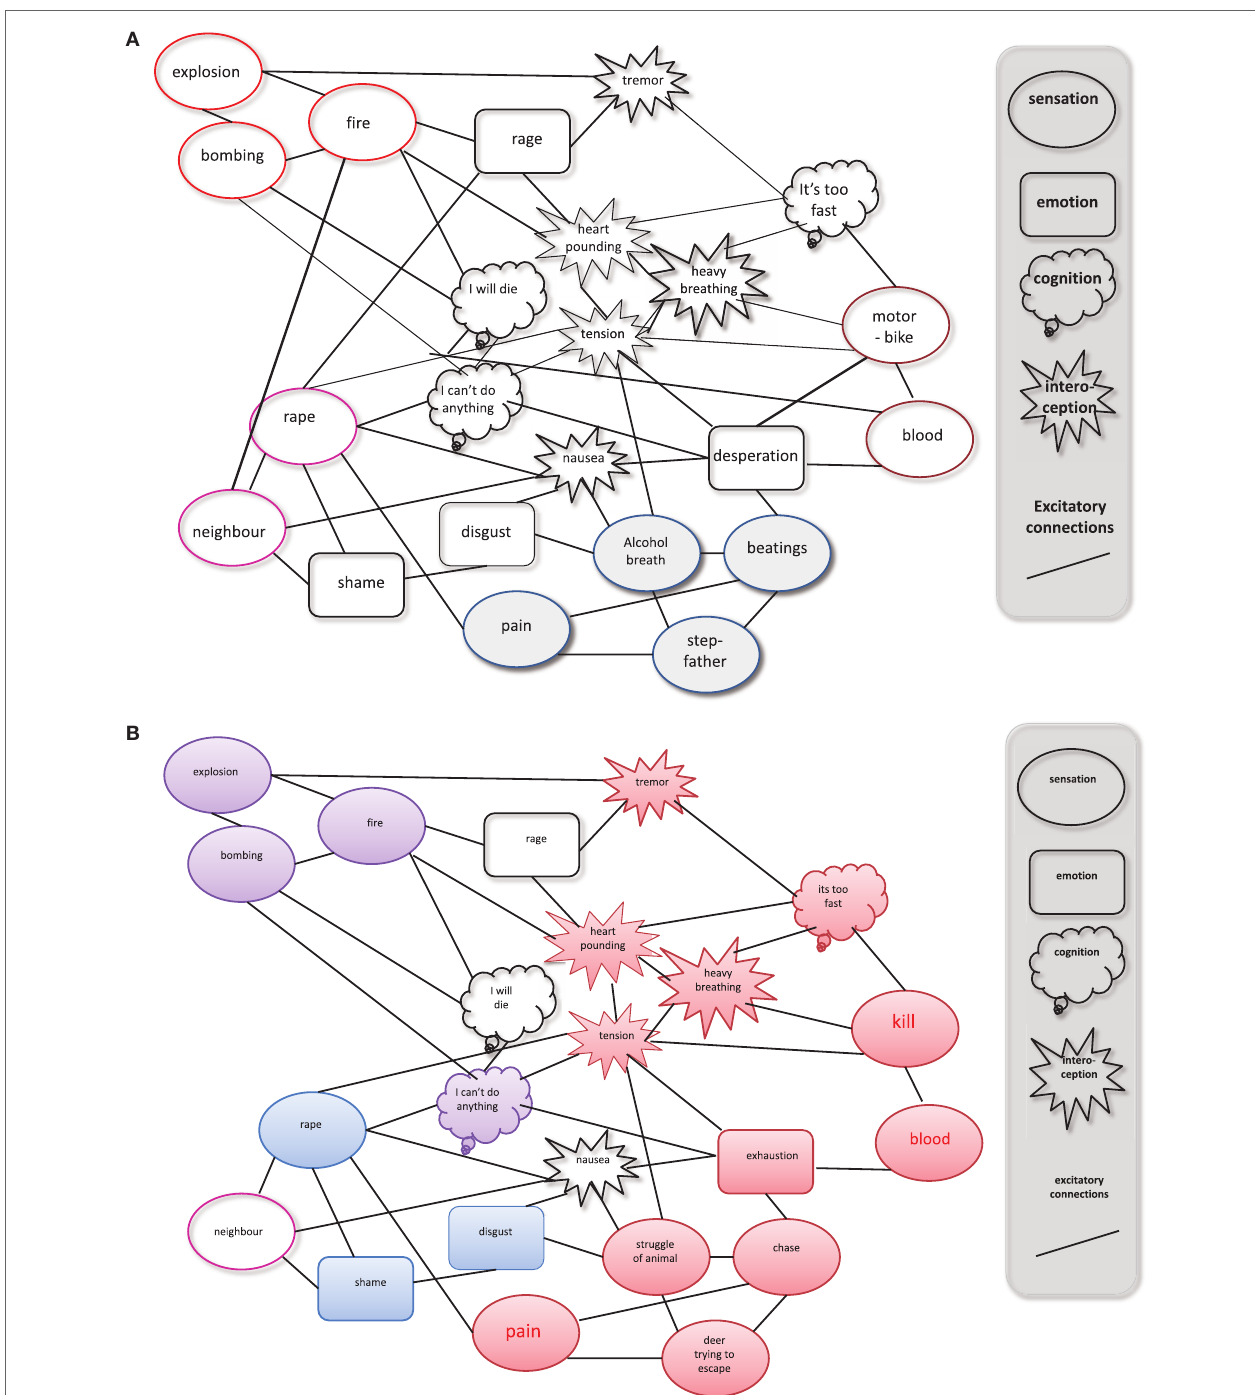
remain largely implicit, making it impossible for the traumatized person to talk about them, a phenomenon, which has been called “speechless terror” (34, 35). (B) Hunting experiences also form a network of related sensory, cognitive, emotional, and physiological memories, which may be very similar to the contents of the fear network. However, the affective valence of much of the emotional experiences and memories is exactly opposite: the fear network links the memories of the event only to negative affect, while the valence of the disposition to hunt is intrinsically positive [from Elbert et al.